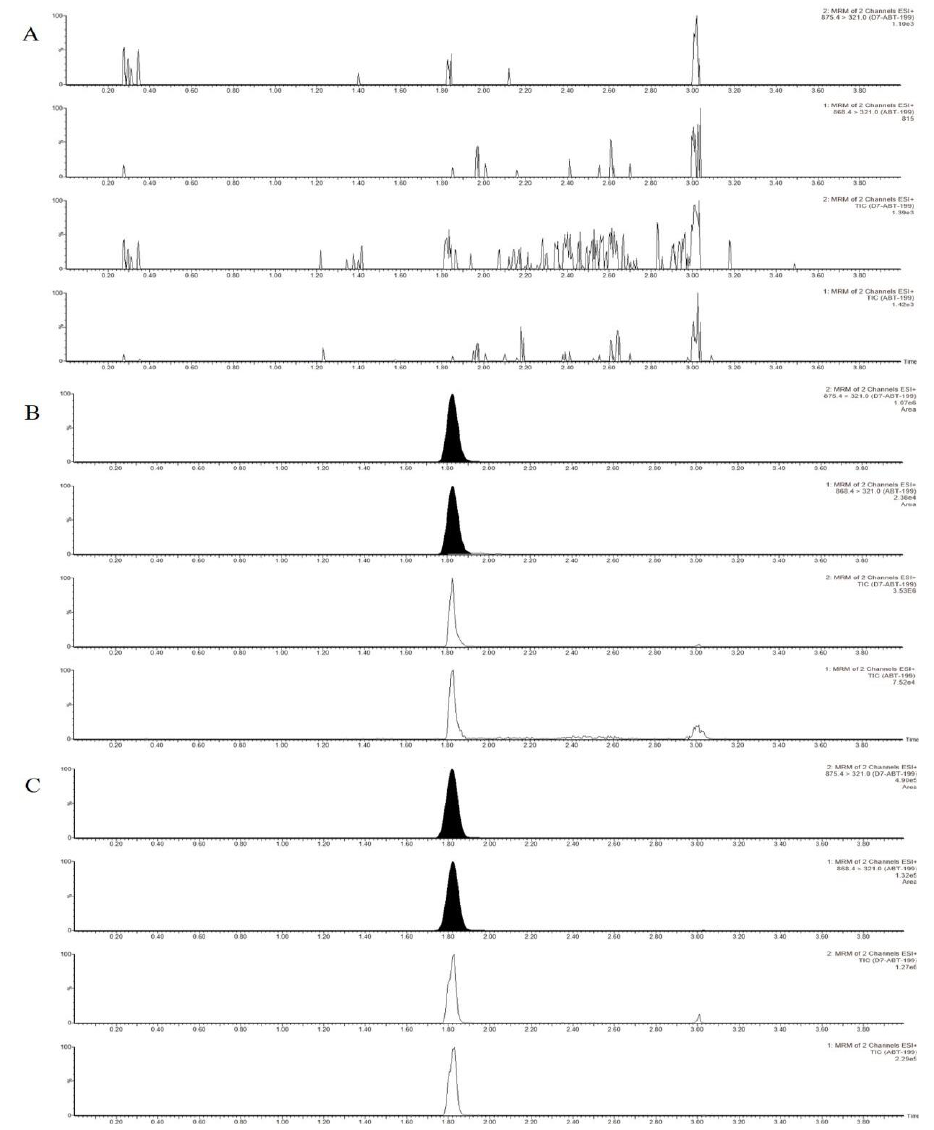
Figure 1. Representative UPLC-MS/MS chromatograms of venetoclax and IS ( A ) — blank plasma; ( B ) — blank plasma-spiking venetoclax and IS; ( C ) — plasma sample 0.5 h before continuous oral administration of venetoclax at steady state).